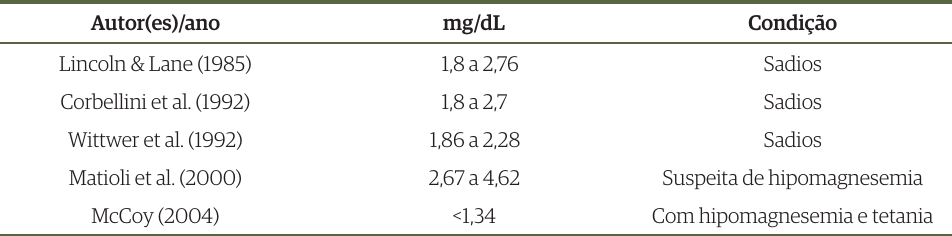
tabela 2. Valores de referência para o magnésio em humor vítreo de bovinos sadios, com suspeita de hipomagnesemia e com hipomagnesemia e